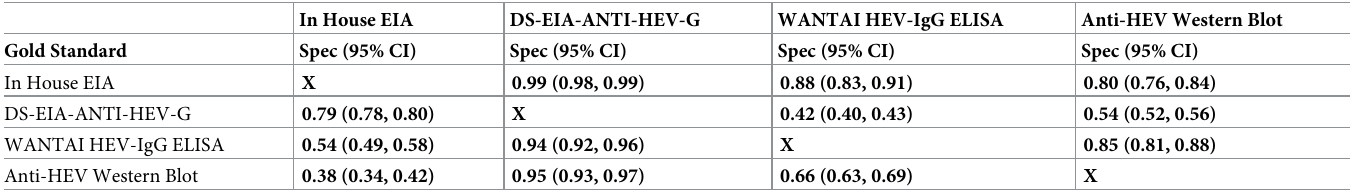
Table 4. Comparative specificity of HEV assays from NHANES